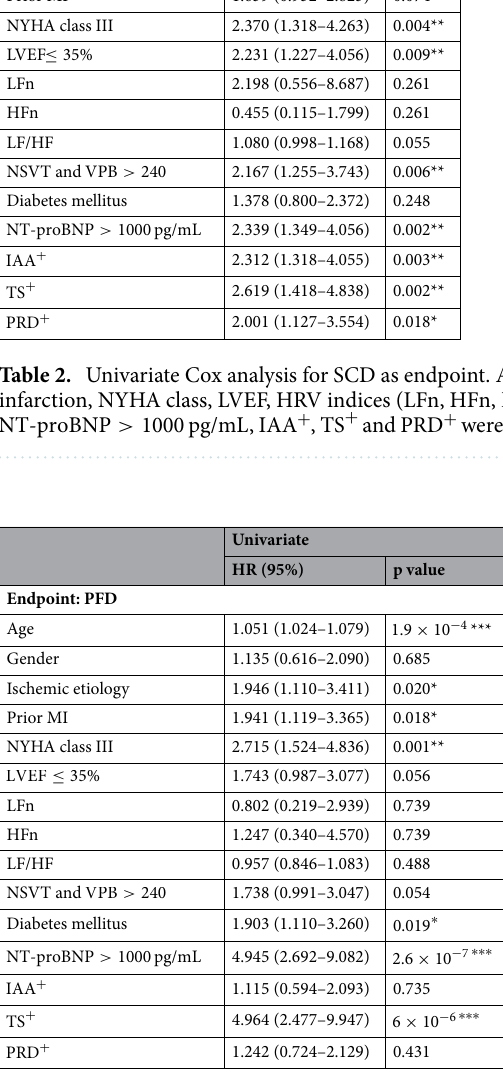
Table 3. Univariate Cox analysis for PFD as endpoint. Age, gender, ischemic etiology, prior myocardial infarction, NYHA class, LVEF, HRV indices (LFn, HFn, LF/HF), combined NSVT and VPB > 240 , diabetes, NT-proBNP > 1000pg/mL , IAA + , TS + and PRD + were the analyzed variables. ∗ p < 0.05 , ∗∗ p < 0.01 , ∗∗∗ p < 0.001